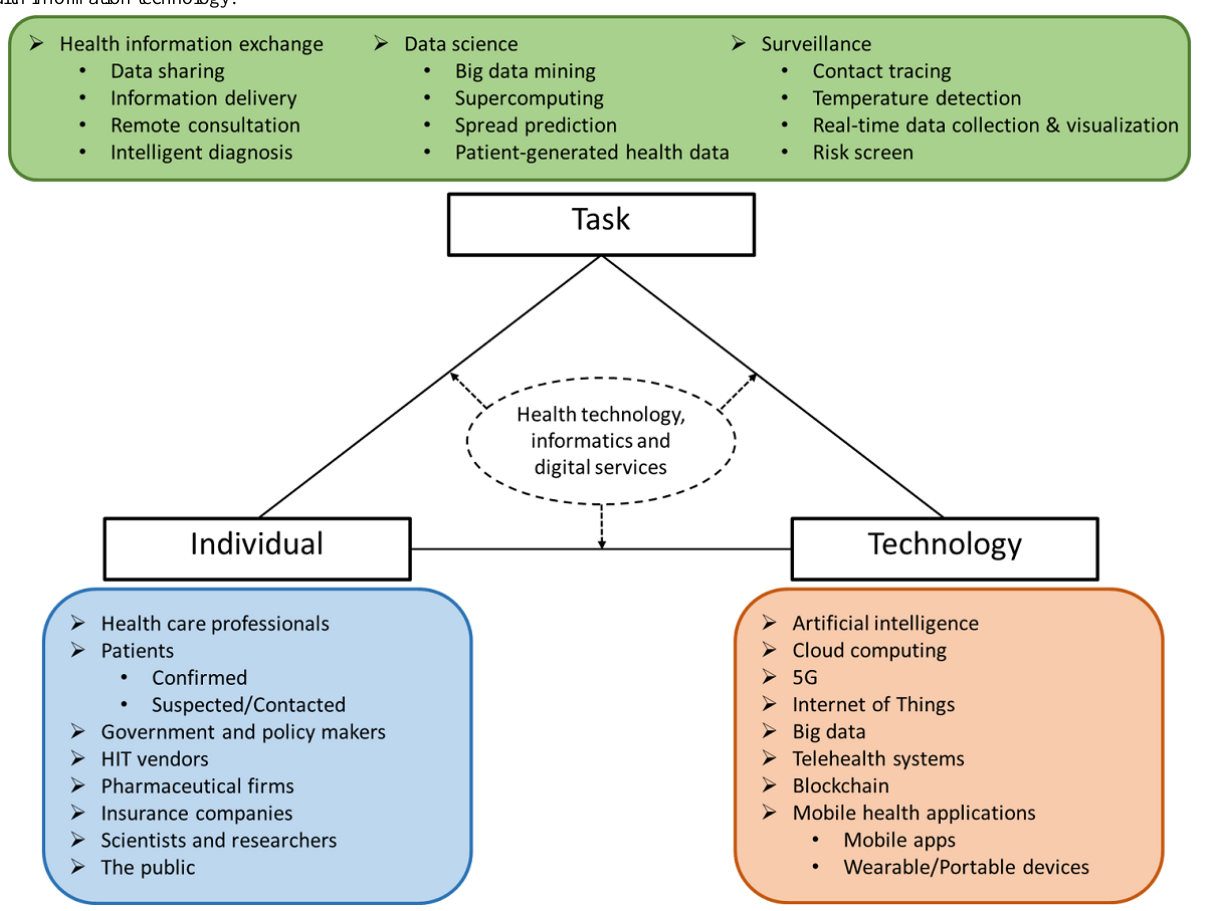
Figure 1. Modified fit between individuals, task, and technology (FITT) framework for health technologies, informatics, and digital services. HIT: health information